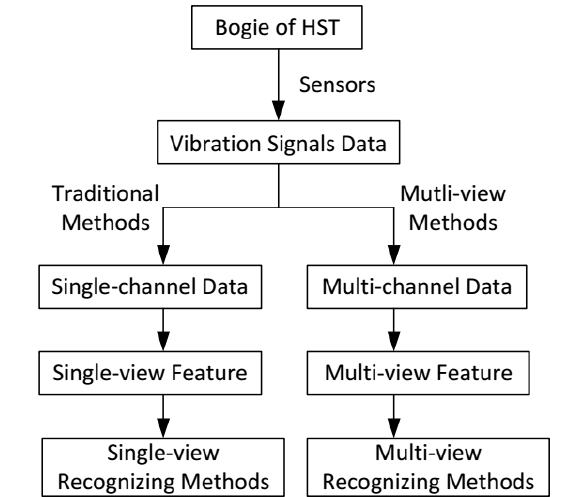
Fig. 2 Process of condition recognition of HST